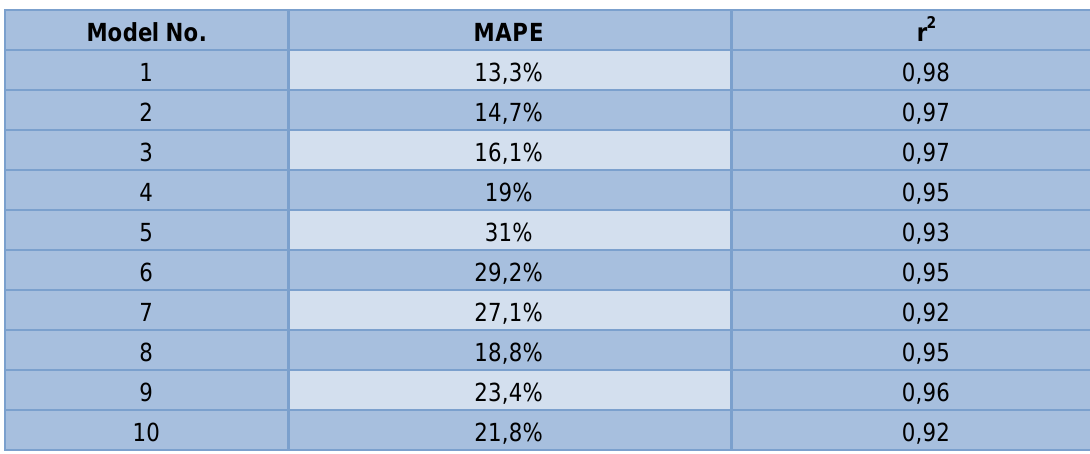
Table 20 Mean absolute percentage error (MAPE) and r2 of the developed regression